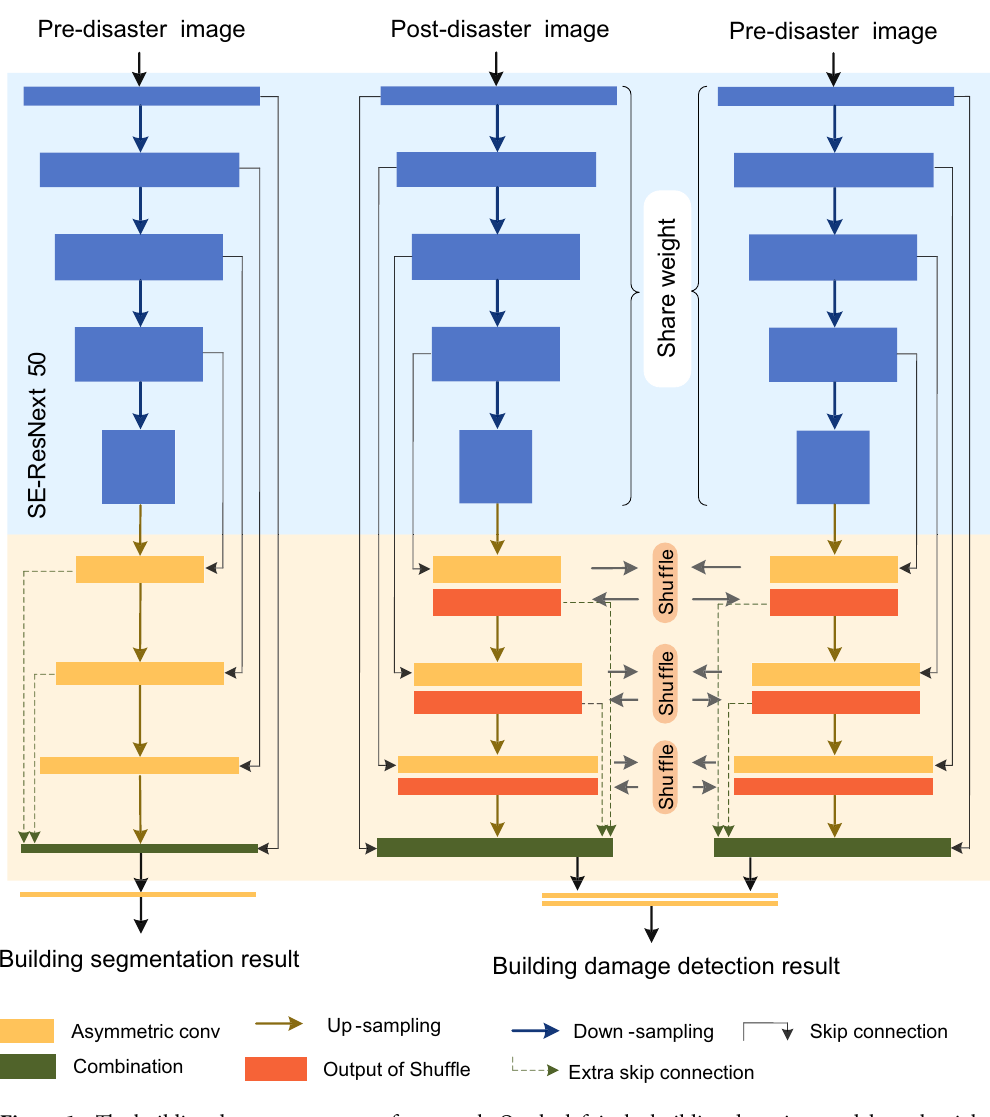
Figure 1. The building damage assessment framework. On the left is the building detection model; on the right is the building damage level classification